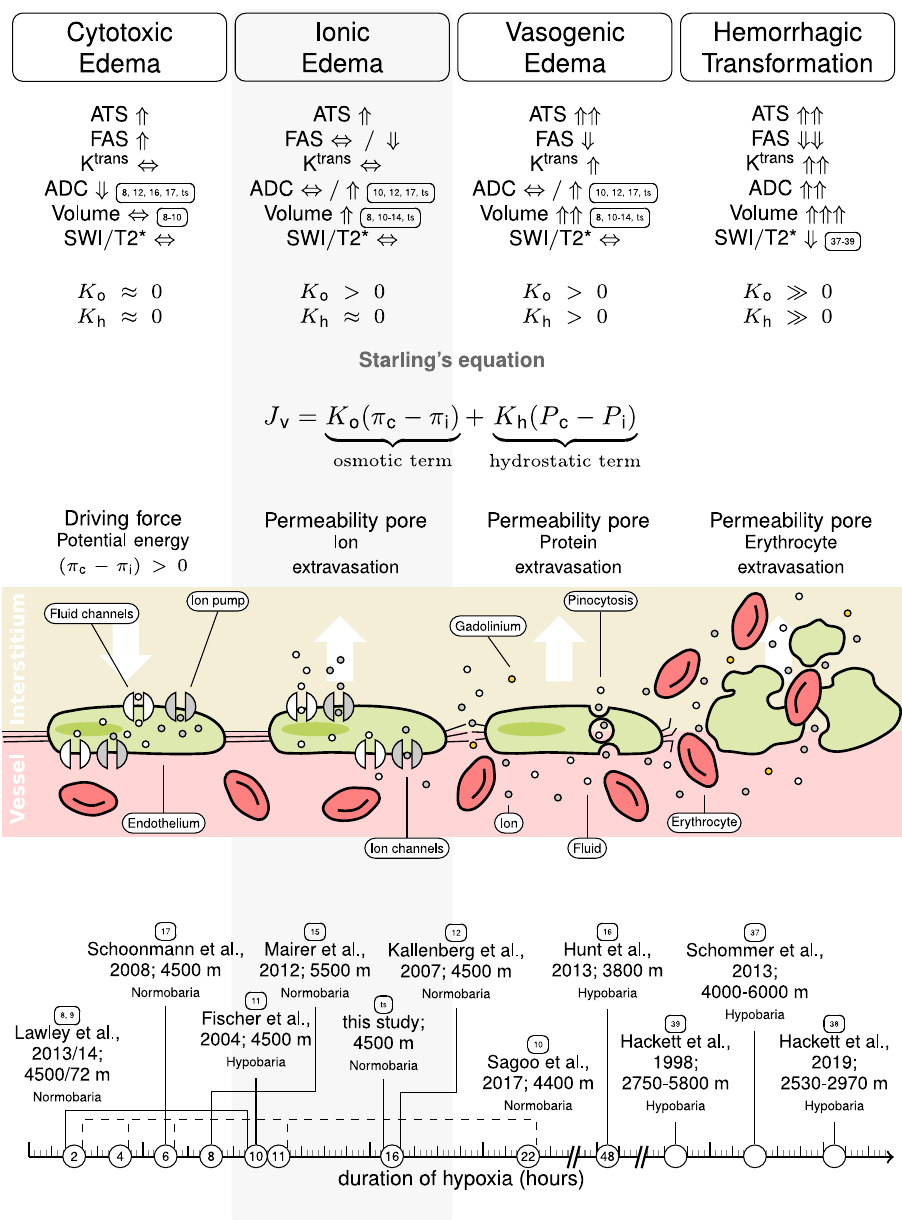
Fig. 1 Stages of cerebral edema formation. 6 . In cascadic models of edema formation the central driving forces are derived from Starling ’ s equation 5,31 : Water fl ux (J v ) across the endothelium depends on capillary ( π c ) and interstitial osmotic pressure ( π p ), the osmotic conductivity coef fi cient (K o ), as well as capillary (P c ) and interstitial hydrostatic pressure (P i ) and the hydraulic conductivity coef fi cient (K h ). ( 1 ) Cytotoxic edema is characterized by intracellular water and sodium ion accumulation ( π c - π i > 0). Fluid shifts are limited to the interstitium, and the blood – brain – barrier is intact. Cytotoxic edema is indicated by increased average tissue sodium (ATS) and fl uid-attenuated sodium (FAS), neutral transfer constant K trans , reduced apparent diffusion coef fi cient (ADC) values, and constant brain volume and susceptibility-weighted imaging (SWI) or T2* values compared to baseline. ( 2 ) Ionic edema is characterized by ion extravasation and extracellular fl uid accumulation; the blood – brain – barrier is intact. In terms of Starling ’ s equation, K o is elevated while the hydrostatic term is around zero. Ionic edemas are consistent with increased ATS, neutral or reduced FAS, constant K trans , neutral or increased ADC, SWI or T2*, and increased brain volume. ( 3 ) Vasogenic edema is determined by ion and protein extravasation, extracellular fl uid accumulation due to an impaired blood – brain – barrier. According to Starling ’ s equation vasogenic edema is de fi ned mainly by the hydrostatic term. Vasogenic edema is consistent with increased ATS, reduced FAS, increased K trans , neutral or increased ADC, SWI or T2*, and increased brain volume. The latter three indicators are nearly identical to (2) rendering it practically impossible to differentiate between vasogenic and ionic edema based solely on canonical proton MRI. ( 4 ) Hemorrhagic transformation is characterized by further blood – brain – barrier disruption, which allows erythrocytes to pass into the interstitium. In Starling ’ s equation, the hydrostatic term increases further. Hemorrhagic transformation is indicated by increased ATS, reduced FAS, increased K trans , increased ADC, increased brain volume, and reduced SWI or T2* signal. The transition between edema types is fl uid and might occur at different rates in different brain areas. The timeline at the bottom of the fi gure sorts previous studies according to the duration of hypoxic exposure. The measurements reported in these studies agree with our predictions as indicated by the numbered